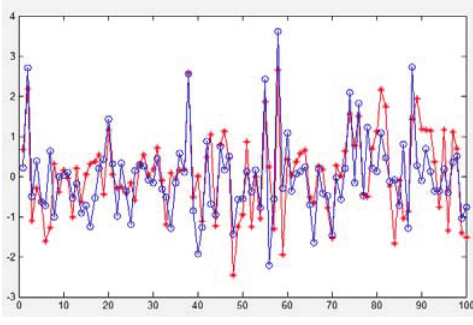
Fig.5 The prediction results of